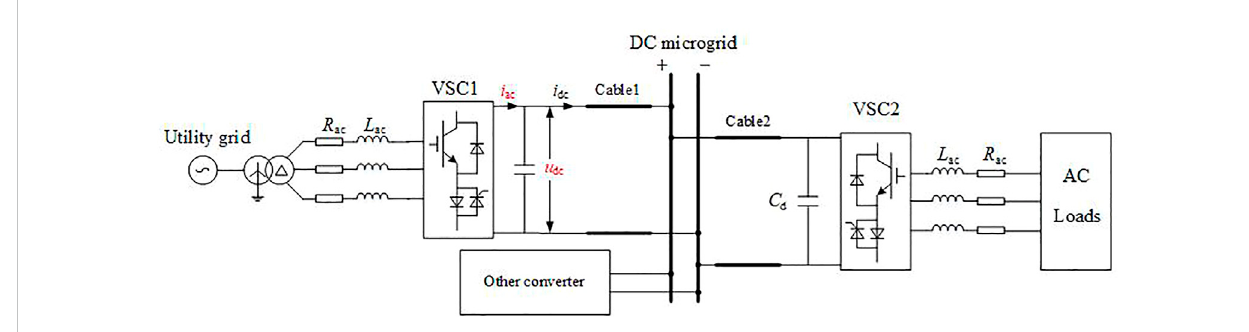
FIGURE 8 Simpli fi ed typical DC micro-grid model.